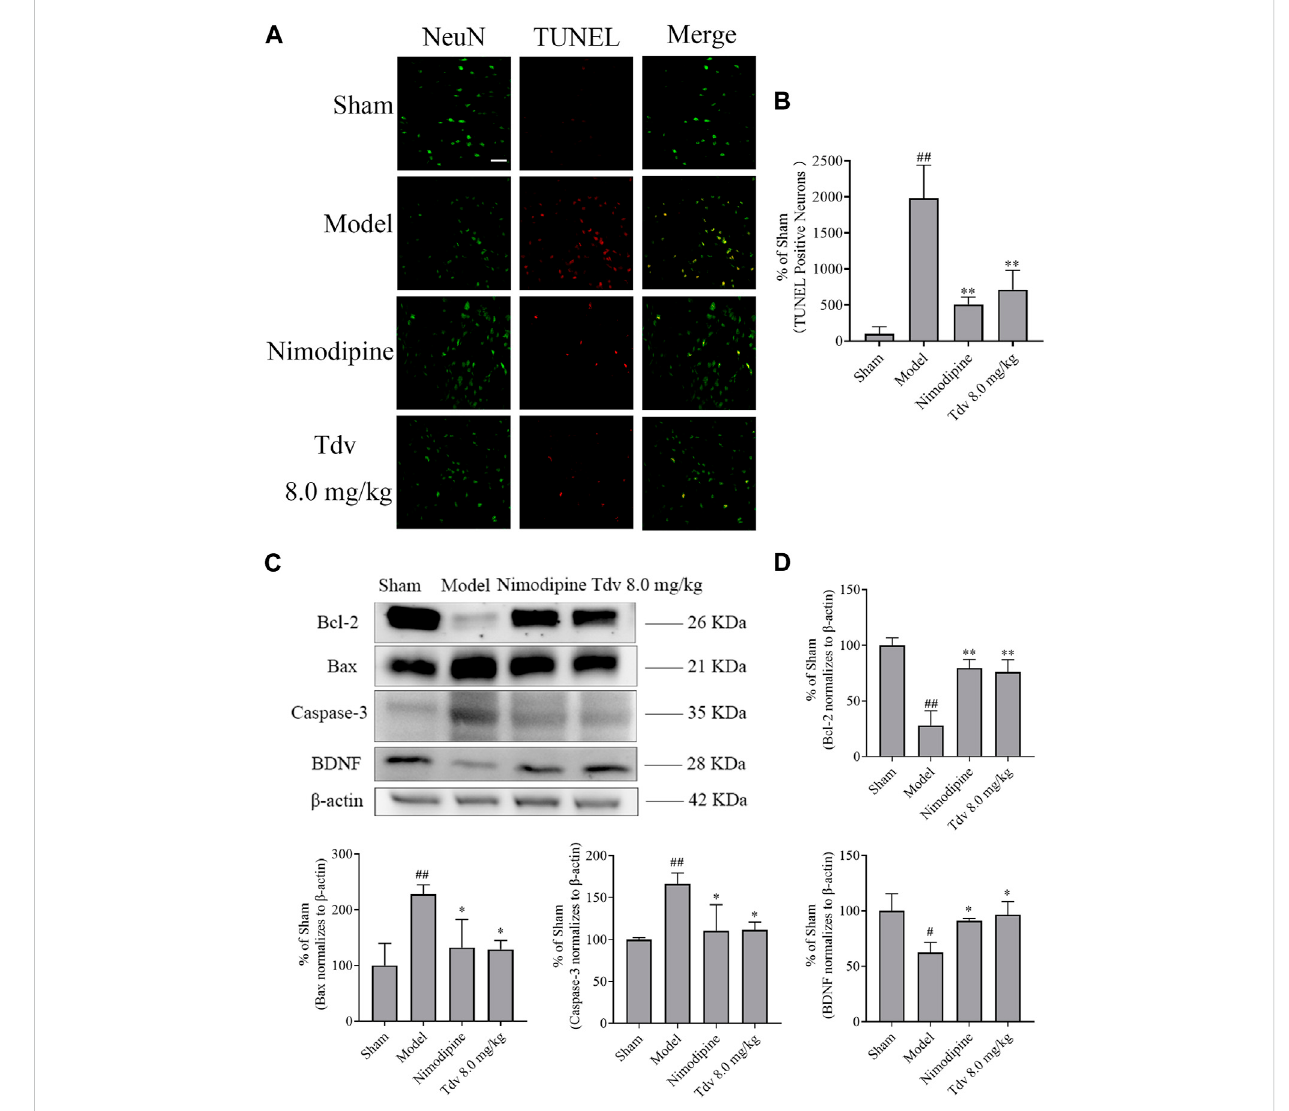
ToludesvenlafaxineincreasedtheexpressionofBDNFanddecreasedapoptosis. (A) TUNELstaining; (B) ThepercentagesofTUNELpositivecells(n= 3); (C) TheexpressionofBDNFandanti-apoptoticprotein; (D) StatisticalresultsofWesternblot.Immuno fl uorescenceofdataaremean±SD,n=3. ## p